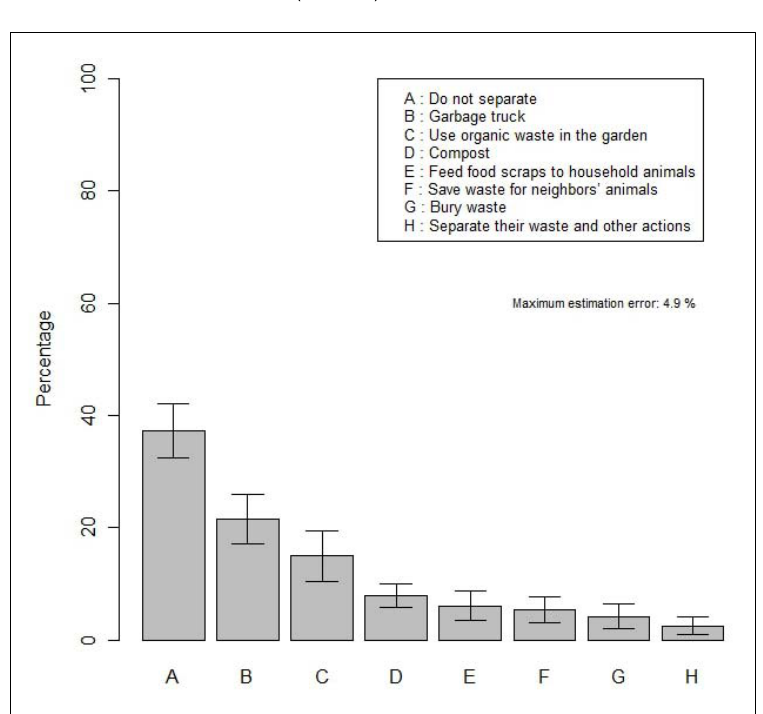
Figure 2. Current Organic Waste Management Practices